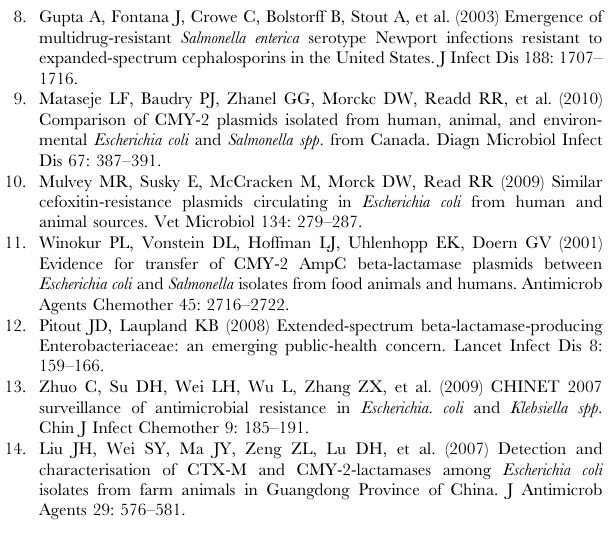
Table S1 Primers used for the PCR amplification of antimicrobial resistance genes. Table S2 Primers used for the PCR amplification of genetic environment of bla CMY-2 gene. Table S3 Primers used for the PCR amplification of integrons. Table S4 MLST Primers used for the PCR amplification of E. coli . Table S5 The number of alleles and ST results for thirty-one CMY-2 producing